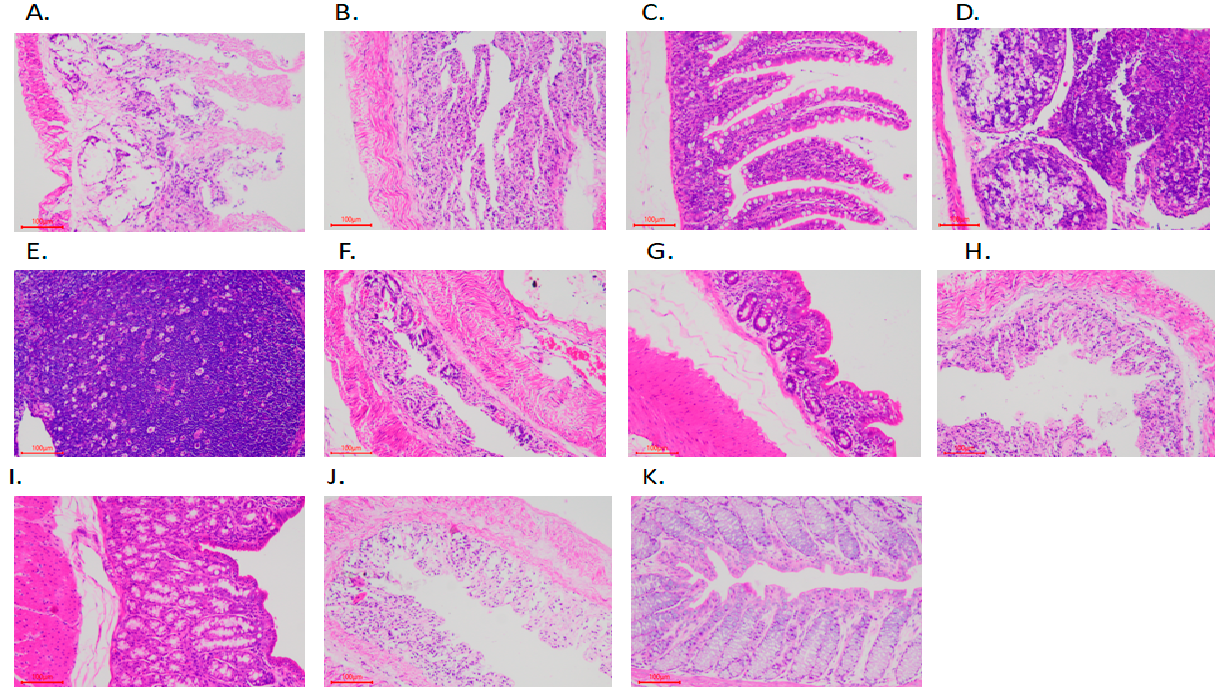
Figure 1. Sections of intestinal tissue samples observed by microscope (HE-staining, 100×). ( A ) The whole layer of coagulative necrosis of the duodenum wall in rabbits with diarrhea. ( B ) The whole layer of coagulative necrosis of the jejunum wall in rabbits with diarrhea. ( C ) The jejunum of healthy rabbits showed normal intestinal structure without obvious histopathological damage. ( D ) The number of lymphocytes in the lymphoid tissue of the lower ileum of diarrheal rabbits decreased seriously, forming a large number of cavities. ( E ) The lymphoid tissue under the ileum of healthy rabbits was rich and arranged in an orderly way. ( F ) The caecum of diarrheal rabbits had coagulative necrosis. ( G ) The intestinal tissue structure of healthy rabbits was normal without obvious histopathological damage. ( H ) The whole layer of coagulative necrosis of the colon wall in rabbits with diarrhea. ( I ) The structure of the colonic intestine in healthy rabbits was normal without obvious histopathological damage. ( J ) The whole layer of coagulative necrosis of the rectum wall in rabbits with diarrhea. ( K ) The structure of the rectum and intestines in healthy rabbits was normal without obvious histopathological damage.